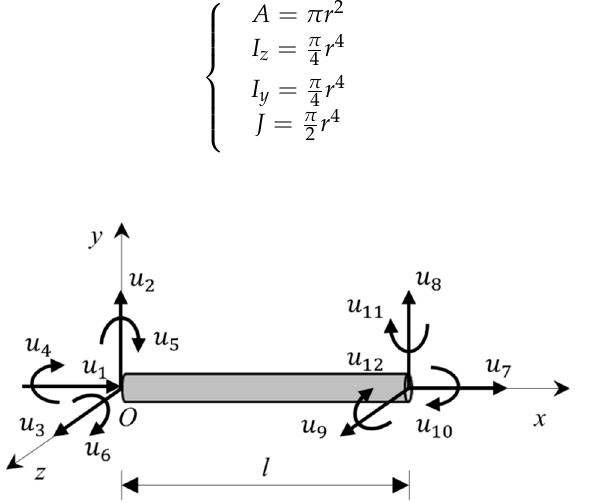
Figure 2. The displacement of lattice beam elements.